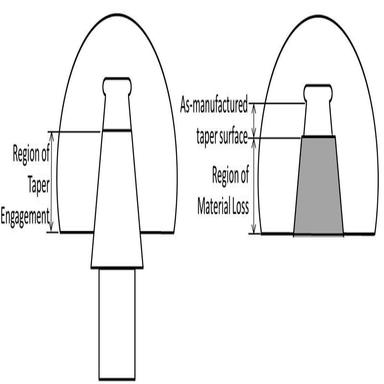
Schematic diagram showing an engaged stem-head couple with a 'Type II′ engagement pattern.